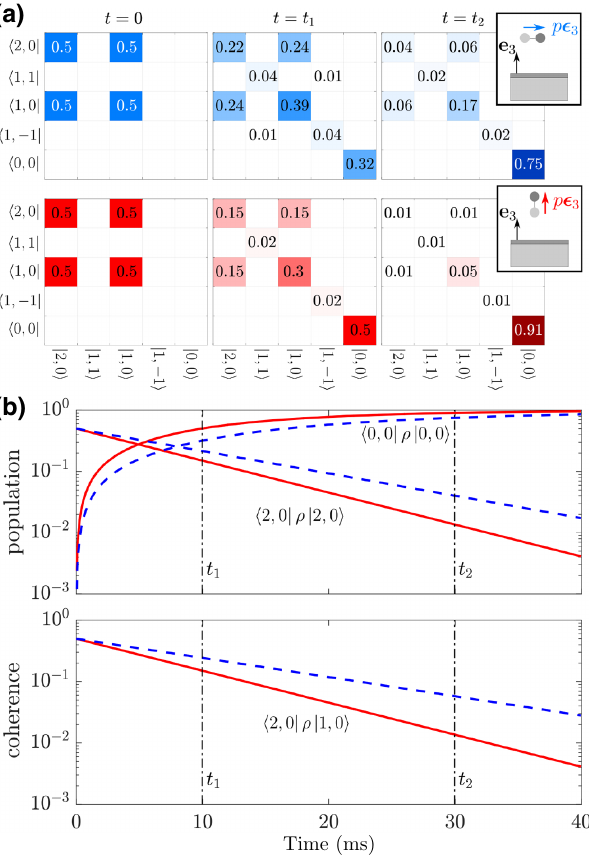
FIG. 4. Rotational decoherence of a point dipole near a super- conducting surface. (a) The particle is initially prepared in an angular momentum superposition state with initial dipole p (cid:2) 3 pointing perpendicular (blue) or parallel (red) to the surface normal vector e 3 . The noise originating from the surface is dom- inated by a thin layer covering the superconducting device (see Sec. V). The dynamics governed by Eq. (69) are displayed via the density operator in the basis of the lowest angular momentum states | (cid:14) m (cid:5) (quantization axis (cid:2) 3 ) for the times t = 0, t 1 = 10 ms, and t 2 = 30 ms. Surface-induced dissipation relaxes the particle to its rotational ground state. (b) (top) While the ground-state population approaches unity for large times, the excited state population decreases at a constant rate. The latter differs in the two scenarios, marked in dashed blue and solid red, respectively. (b) (bottom) The coherence decay in (a) also occurs at a con- stant rate. Decoherence in the red case is stronger, since the field fluctuations are stronger in the direction of the surface